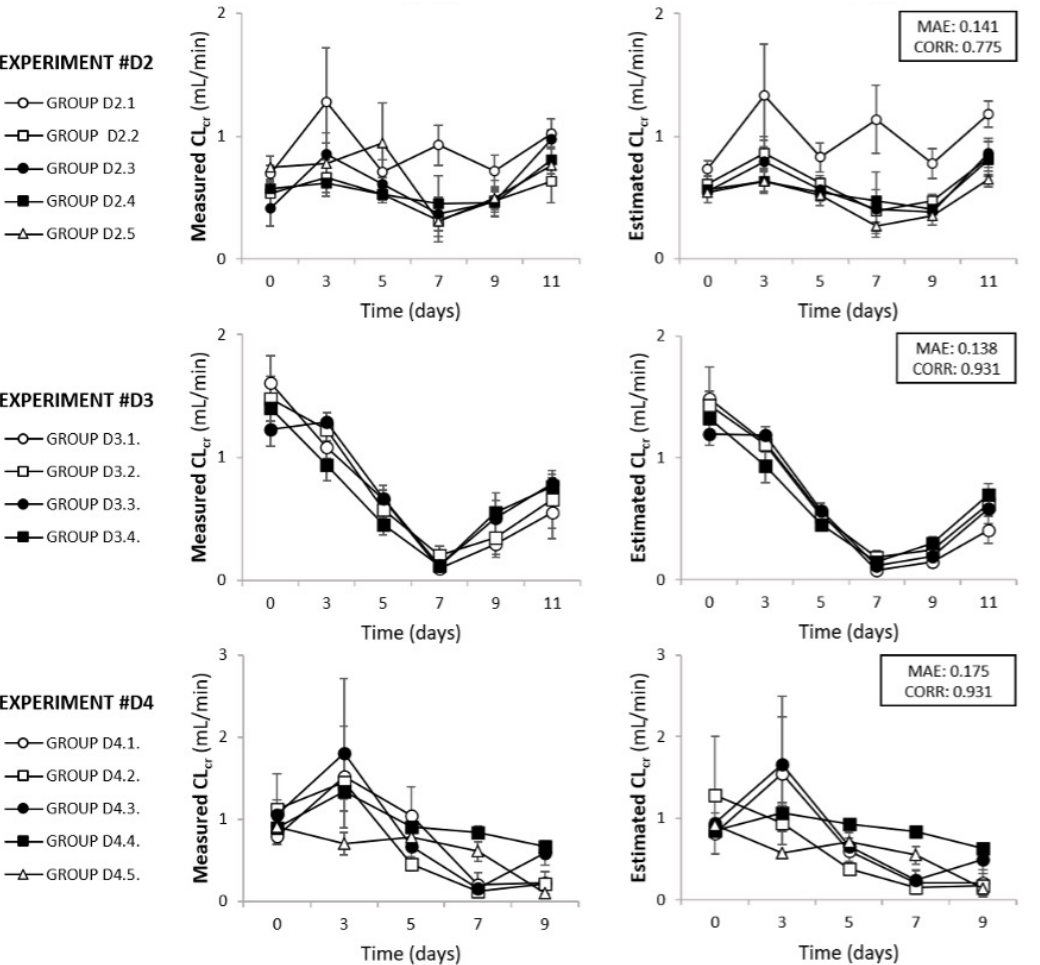
Figure 2. Comparison of the measured ClCr and estimated ClCr, corresponding to four exemplifying actual experiments using data from the training and validation sets. ClCr, creatinine clearance. CORR, Pearson product-moment correlation coefficient. MAE, mean average error.